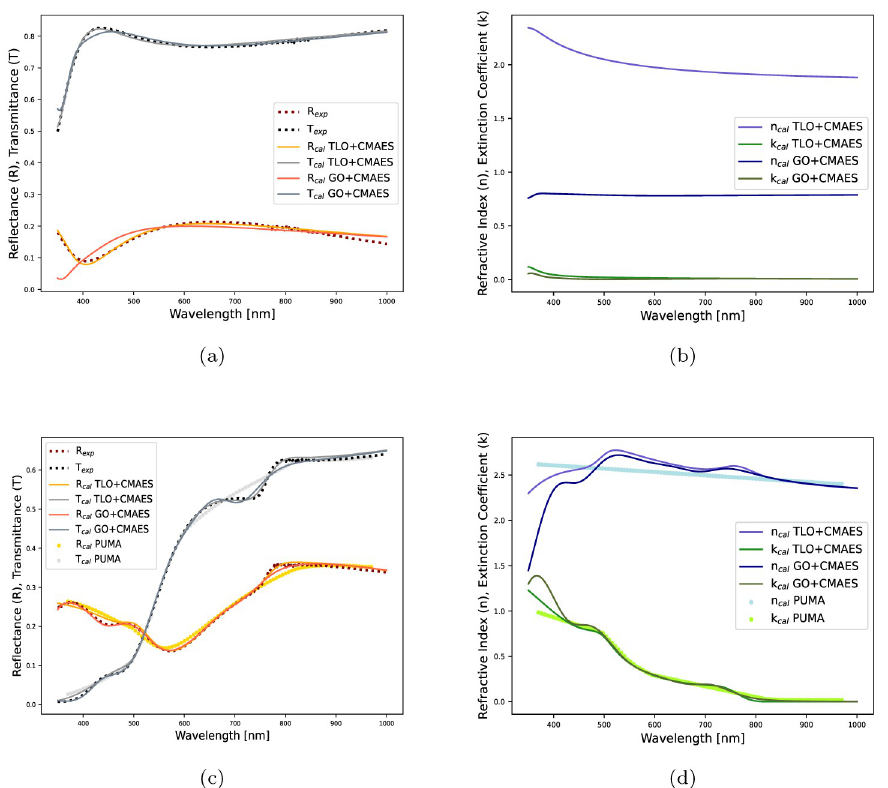
Fig 7. Estimated optical constants from the experimentally measured spectra of two different films: (a) Measured vs. estimated spectra for ITO film, (b) Estimated refractive index and extinction coefficient estimates of ITO film. (c) Measured vs. estimated spectra for MAPbI 3 film, (d) Estimated refractive index and extinction coefficient estimates of MAPbI 3